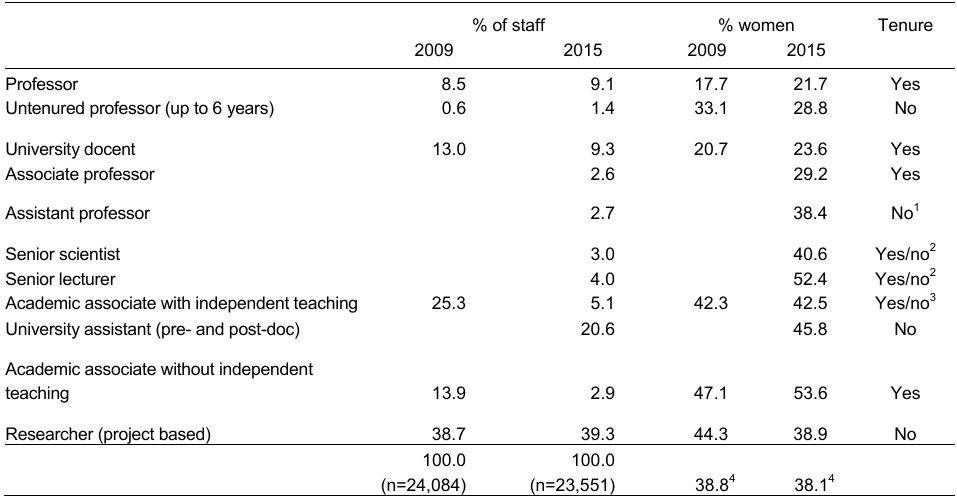
Table 1 : Scientific staff at Austrian public universities by position 2009 and 2015 (winter term) % of